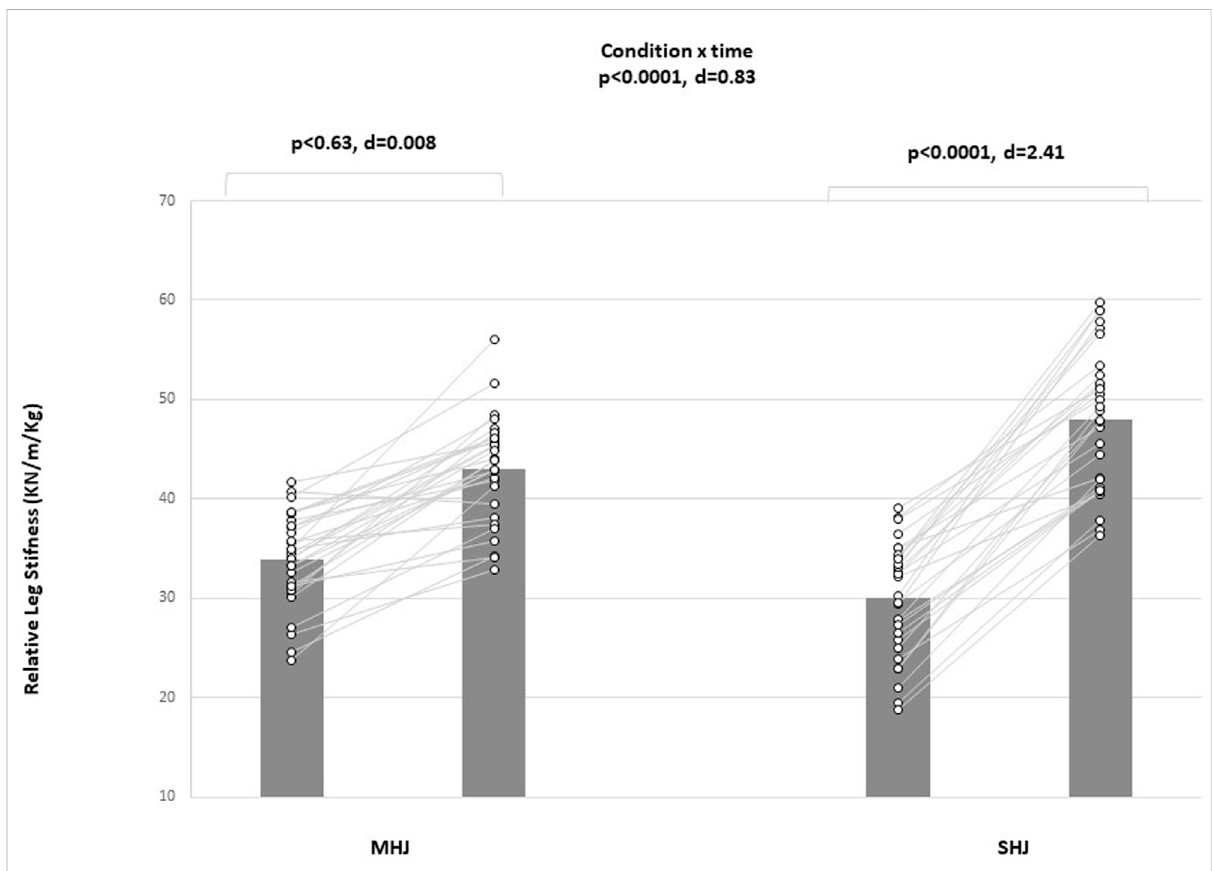
FIGURE 4 Mean values (black) and individual scores (white) for relative leg stiffness pre- and post-intervention; d, Cohen ’ s d; MHJ, maximal hurdle jump; SHJ, submaximal hurdle